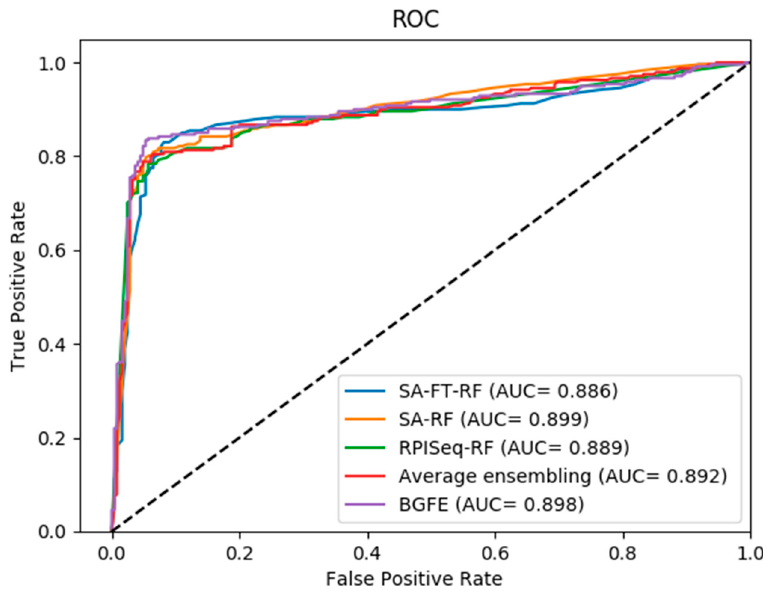
Figure 2. ROC curves of performance comparisons between BGFE and other strategies on dataset RPI488.